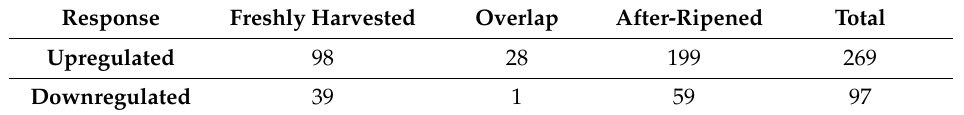
Table 1. The numbers of up- and downregulated phosphopeptides in barley grains during imbibition. Figure 2. Comparative analysis of FH and AR barley grains. Quantitative data of each Response phosphopeptide in FH and AR grains was displayed as a heatmap. Phosphopeptides could be classified into clusters a, b and c based on their phosphorylation patterns. Cluster a (red) and cluster b (green) include phosphopeptides primarily showing large increases in FH and AR grains, respectively. The cluster c (black) includes phosphopeptides that showed similar tendencies in both samples.